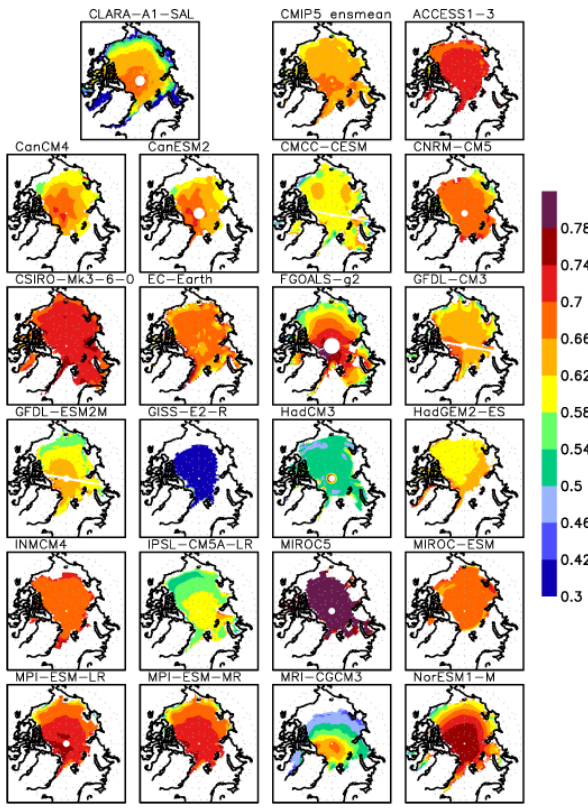
Fig. 5. Summer-averaged (JJA) sea ice albedo, as derived from the satellite data and the CMIP5 model ensemble. Shown is the time average over 1982–2005.